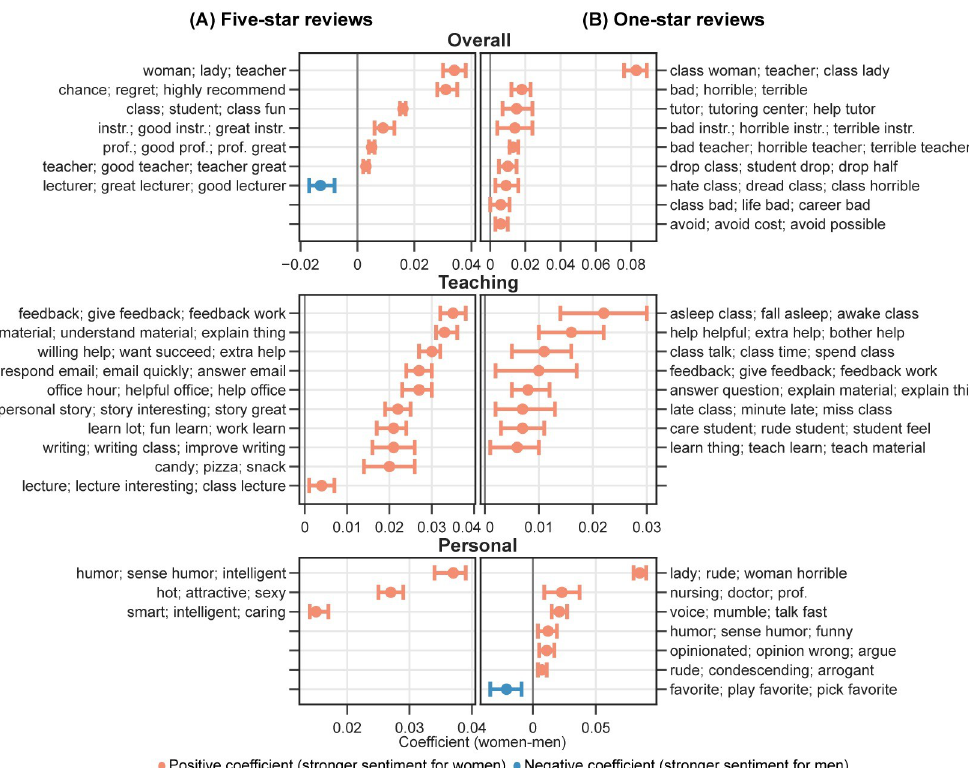
Fig 9. Regression analysis of predicted sentiment scores by professor-level topic dimensions. Orange and blue marks denote positive and negative coefficients of gender (1 = women), respectively. Only gender-significant topics where gender is a significant contributing factor in the regression analysis are shown. prof. = professor; instr. = instructor. (A) Regression analysis of five-star reviews based on positive sentiment scores. (B) Regression analysis of one-star reviews based on negative sentiment